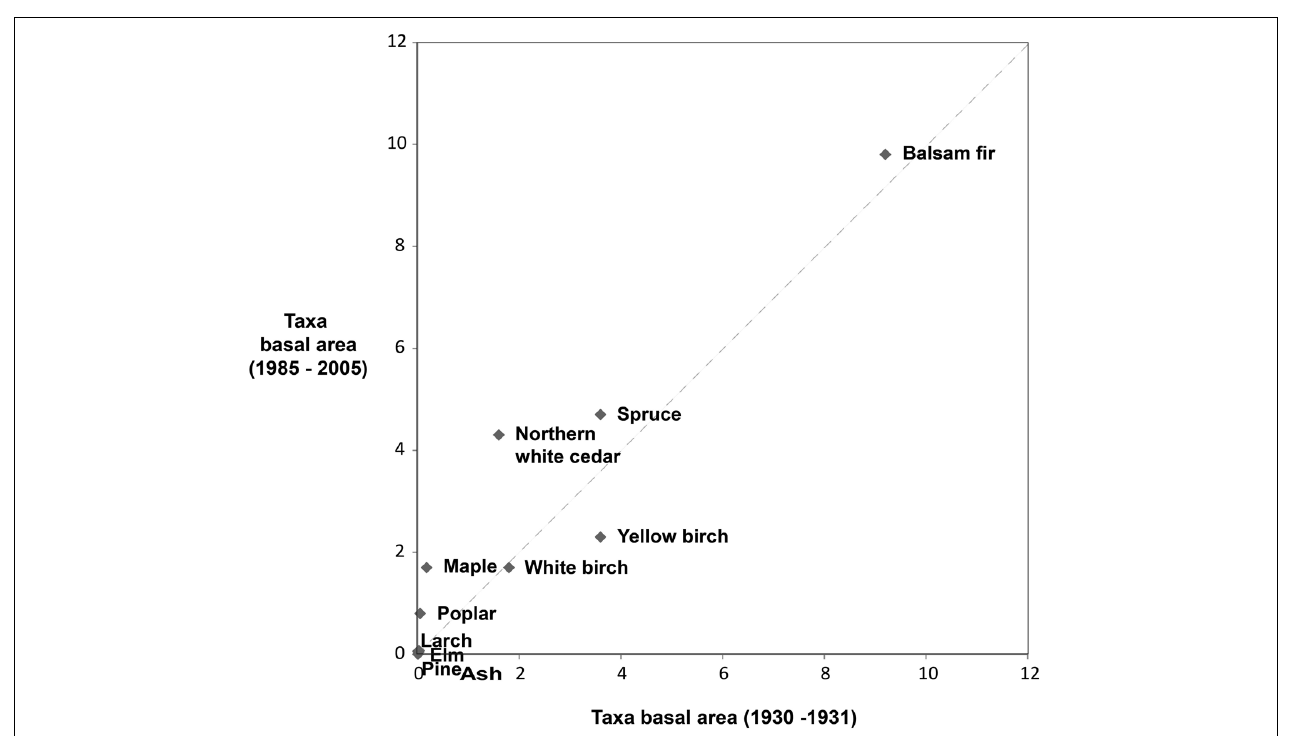
FIGURE 8 | Taxa basal area (m2.ha-1) in 1930–1931 and 1985–2005 in naturally regenerated